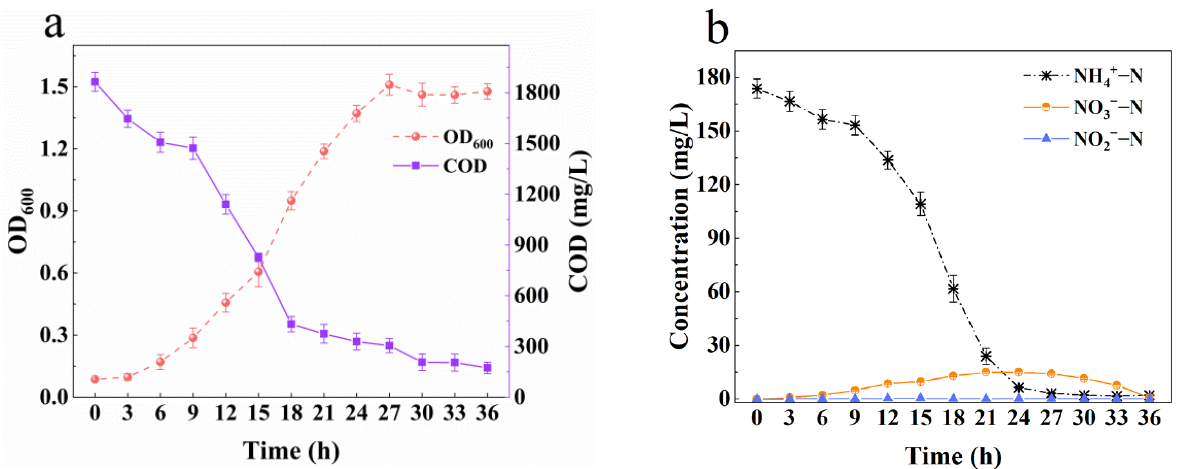
Figure 3. ( a ) The growth curve and COD removal capacity of strain LY1024; ( b ) heterotrophic nitrification performance of strain LY1024.